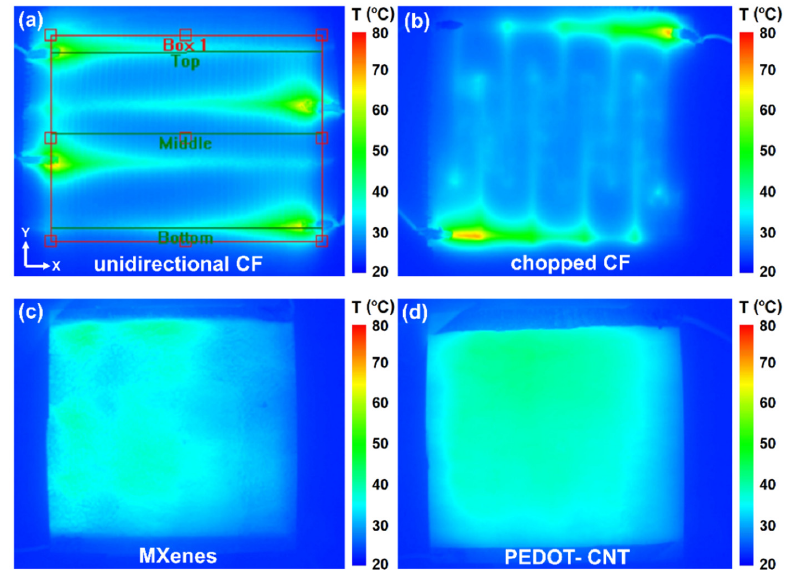
Figure 6. Thermal imaging analysis under 1.86 W power and 300 s of: ( a ) unidirectional CF; ( b ) chopped CF; ( c ) 5-layer MXene and ( d ) 8-layer PEDOT-CNT coatings.